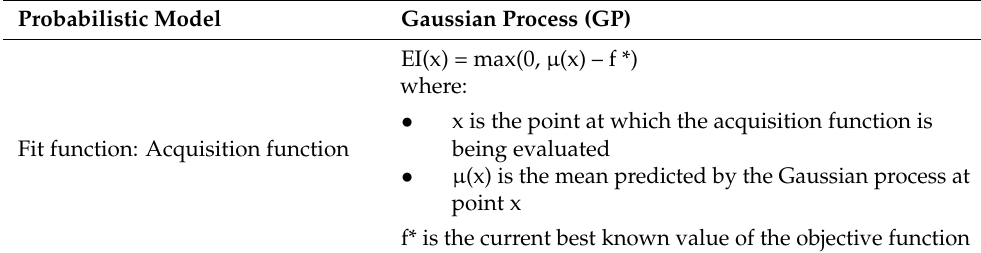
Table 5. Bayesian optimization algorithm